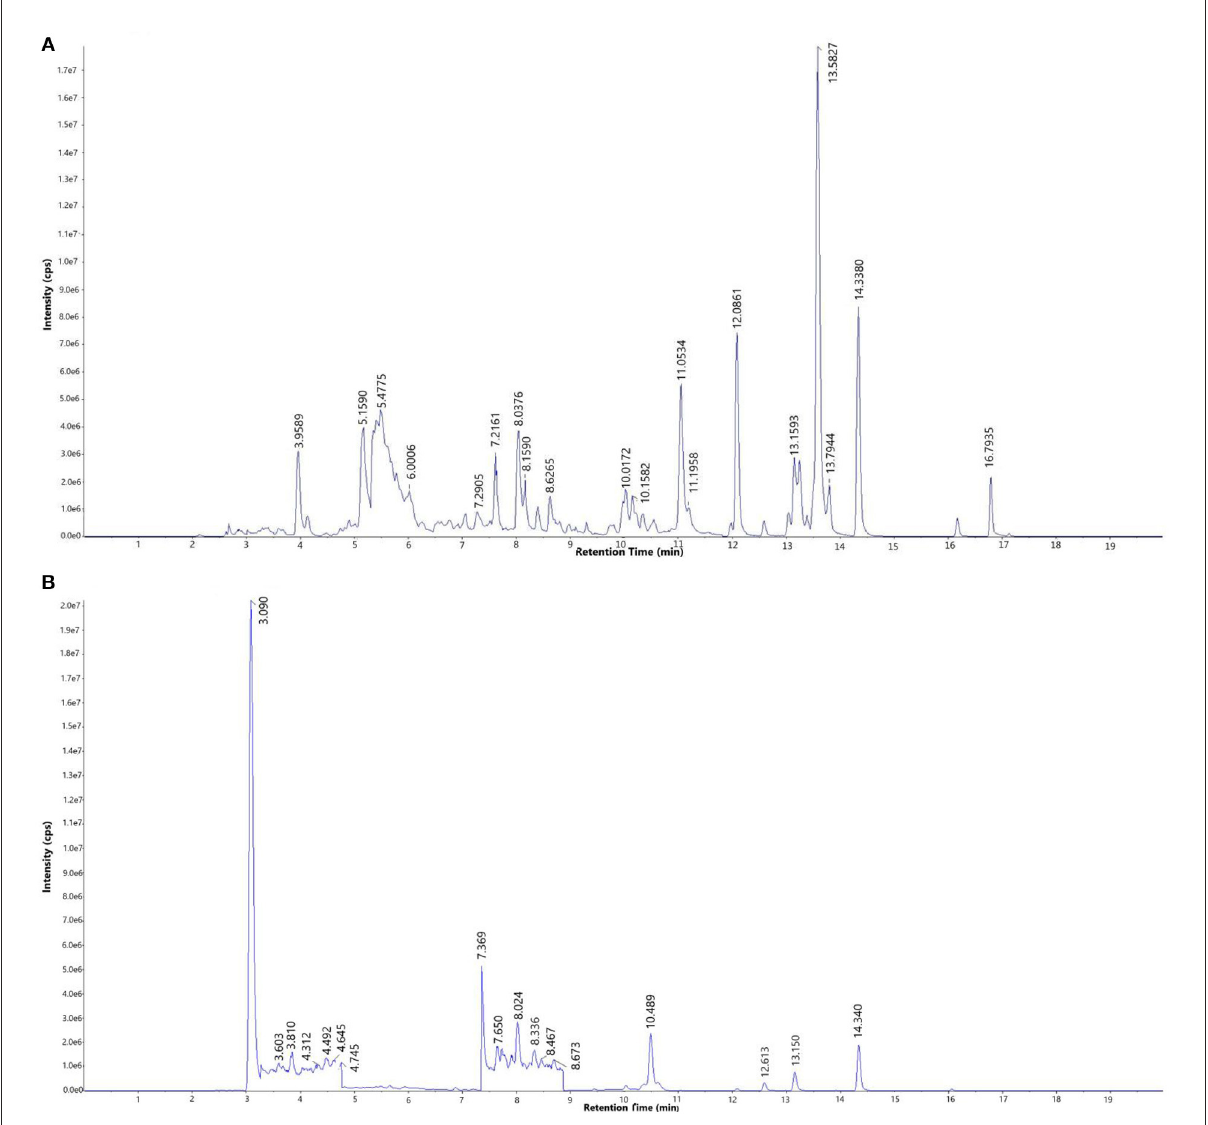
FIGURE1 Total ion current chromatogram (TIC) of (A) mixed standard and (B) purified flavonoids from M. crystallinum